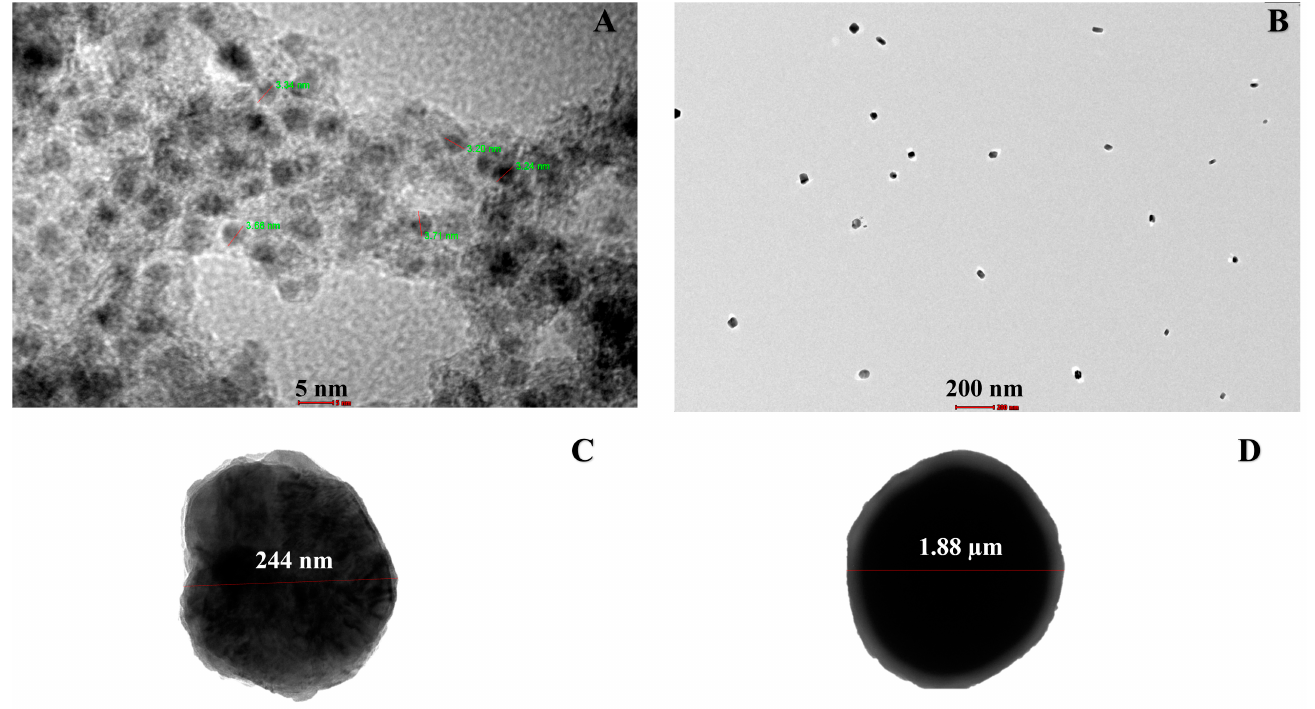
Figure 8. TEM images of synthesis nanoparticles at: ( A ) 280 kx; ( B ) 7.8 kx; ( C ) 62 kx; and ( D ) 6.5